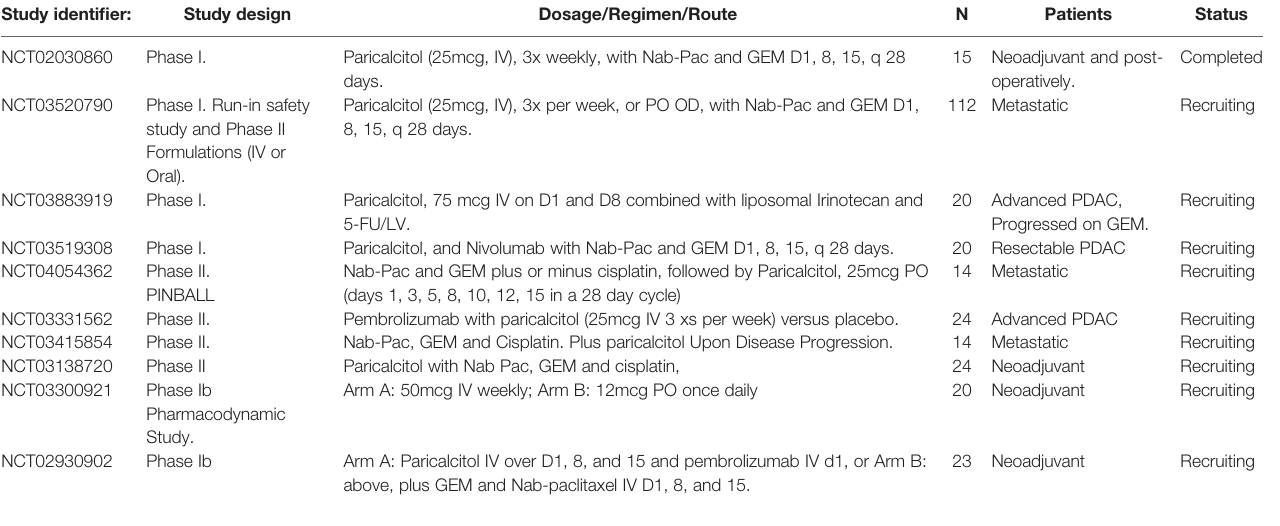
TABLE 5 | Completed and ongoing clinical trials involving Paricalcitol in patients with PDAC. Study identi fi